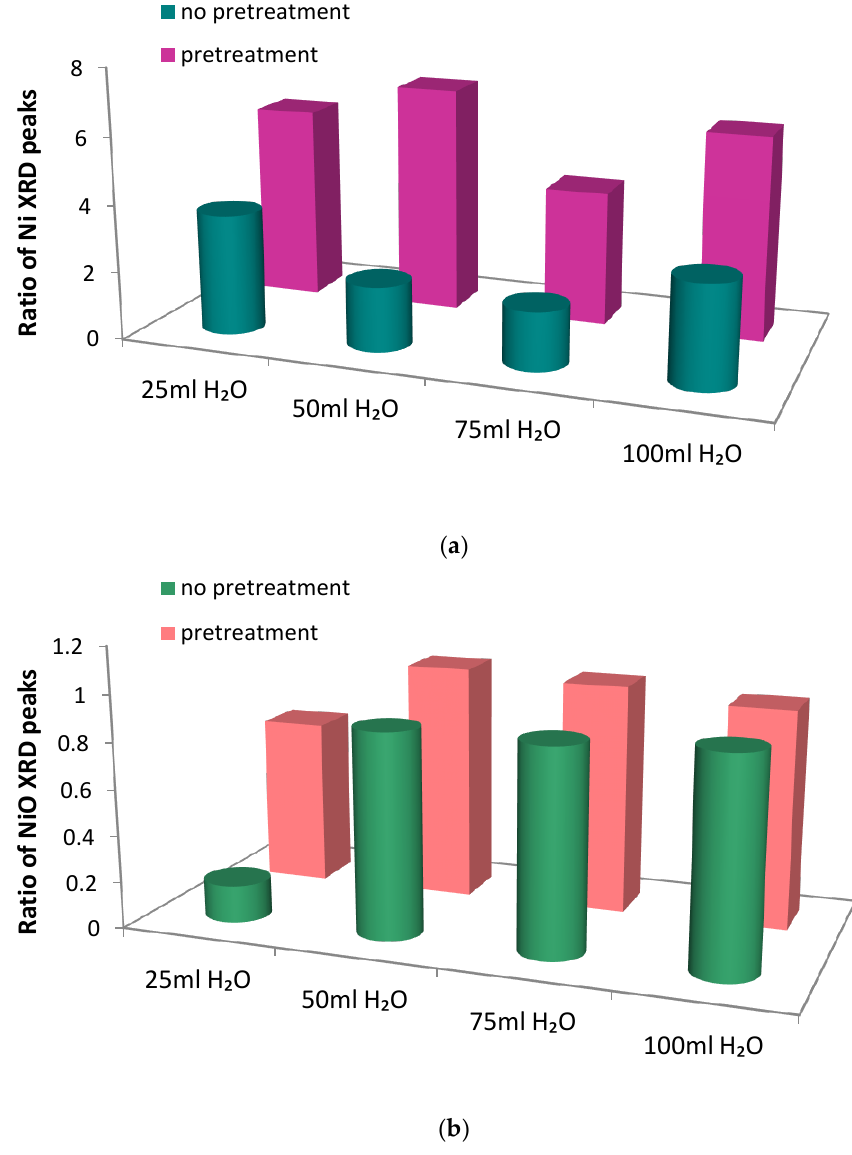
Figure 3. Semi-quantitative analysis of the ( a ) Ni and ( b ) NiO phases in the resulting materials. Based on the data obtained by the XRD patterns, the heated stirring appeared to have a major influence on the final products’ composition. When heated stirring was applied in the precursor SCS solution up to 70 °C, the concentration of nickel in the final product was strongly enhanced, thus improving their catalytic activity in the liquid-phase hydrogenation of maleic acid. The pretreatment influenced the nickel nitrate–glycine complexes that were formed in the precursor solution in the form of dendrites, which play a key role in the SCS reaction mechanism and the formation of nickel. When these dendrites existed (with pretreatment) the reaction took place at lower velocity, as it was yielded through their complicated structure, and thus there was less time available for the oxidation of nickel. Furthermore, the heated stirring before SCS had a considerable effect on the nanopowders’ microstructure as shown in Figures 4 and 5 that exhibit the calculated crystal lattice spacing and crystallite size for nickel and nickel oxide. The standard deviation for the crystal lattice spacing values was estimated to be ±0.0005 Å with a crystallite size of ±3 nm.